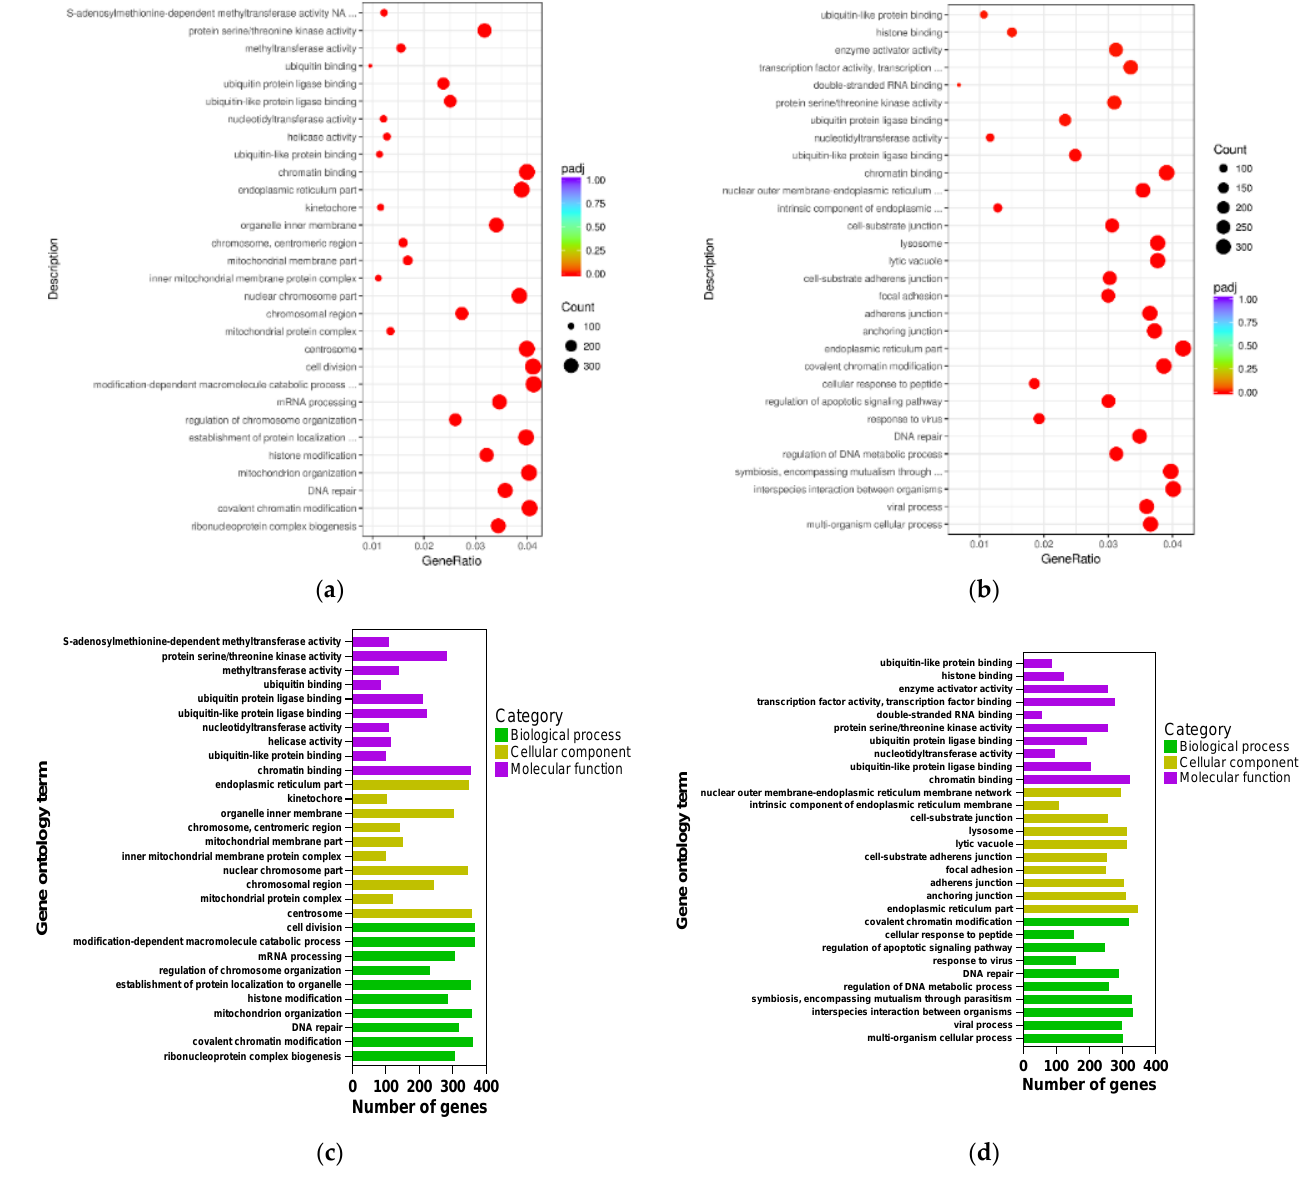
Figure 5. The GO analysis of all DEGs ( a ) gene ratio in 160/LPS, ( b ) gene ratio in 320/LPS, ( c ) number of genes in 160/LPS, ( d ) number of genes in 320/LPS. The padj is a p -value after correction for multiple hypothesis testing. The gene ratio is a ratio of the number of differential genes annotated to the GO term to the total number of differential genes.